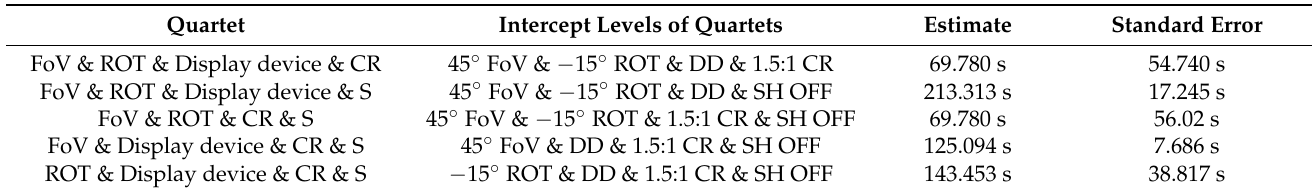
Table 5. The investigated quintets, their intercept values, estimates, and standard errors.